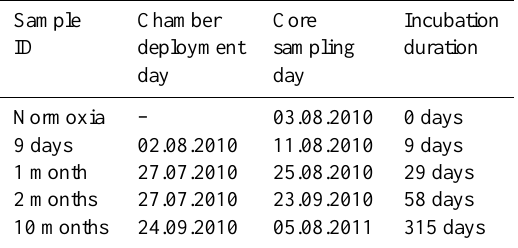
Table 1. Deployment and sampling dates as well as duration of the experimental period for the cores representing in situ conditions (“Normoxia”) and the various periods of anoxia in the four different benthic